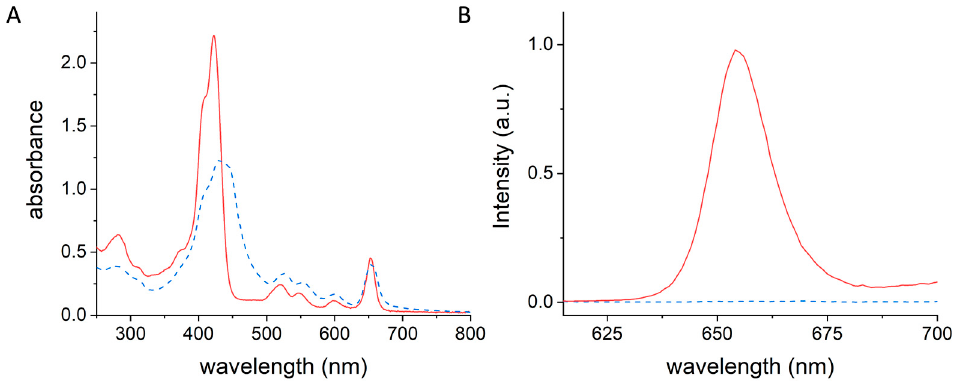
Figure 7. ( A ) UV-Vis absorption spectra and ( B ) emission spectra ( λ ex = 597 nm) of mTHPC@apoMb (solid red line) and mTHPC in PBS (dashed blue line).